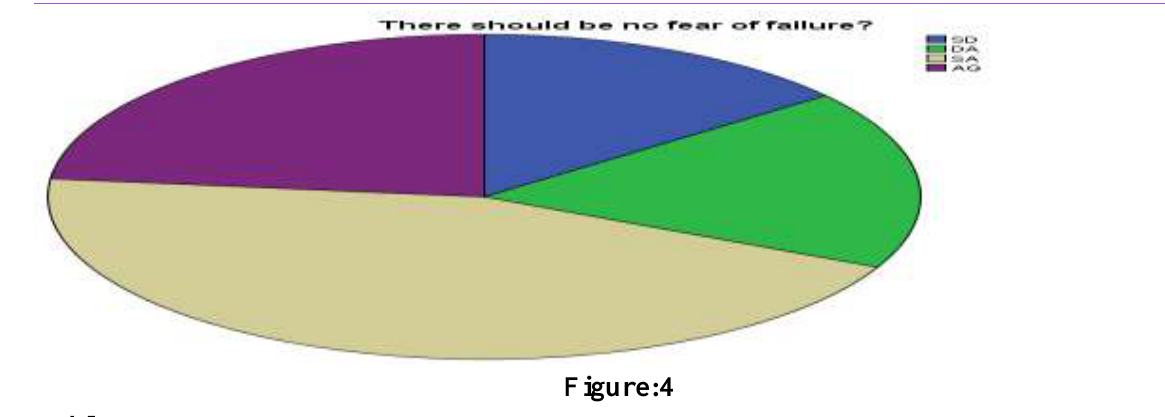
Teacher should not ignore the ethnicity and academic background of every individual? Valid Frequency Percent Percent Cumulative